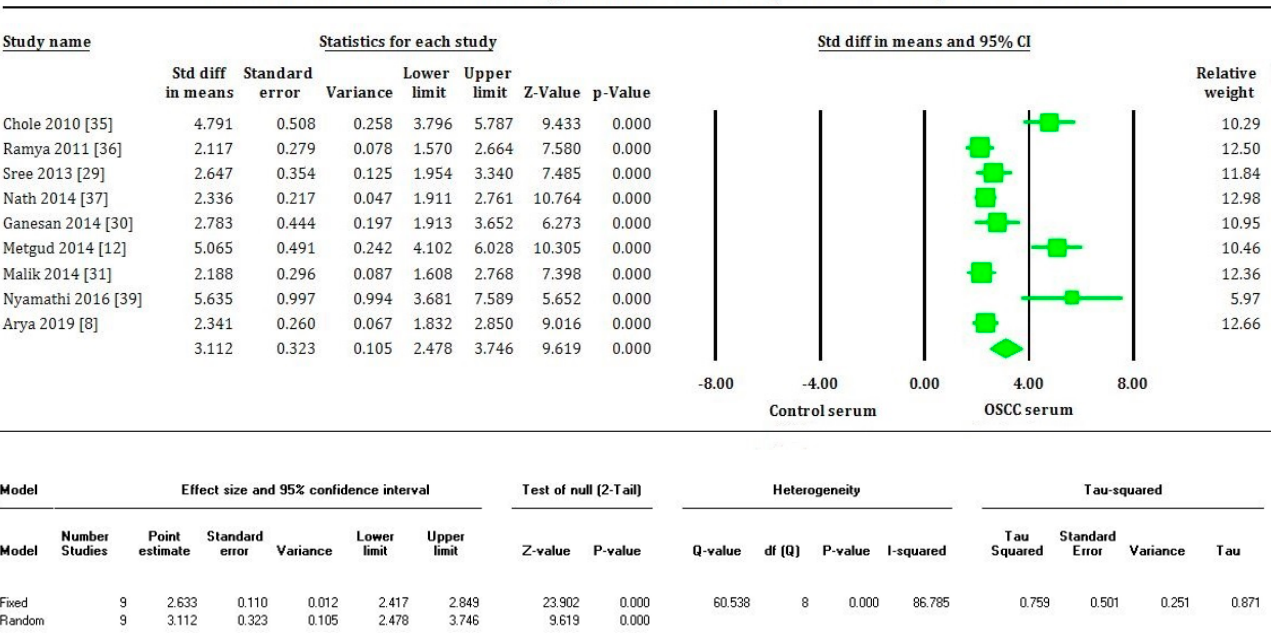
Figure 2. Forest plot shows mean difference estimates with 95% confidence intervals representing differences in plasma levels of MDA between the oral squamous cell carcinoma group and healthy controls.